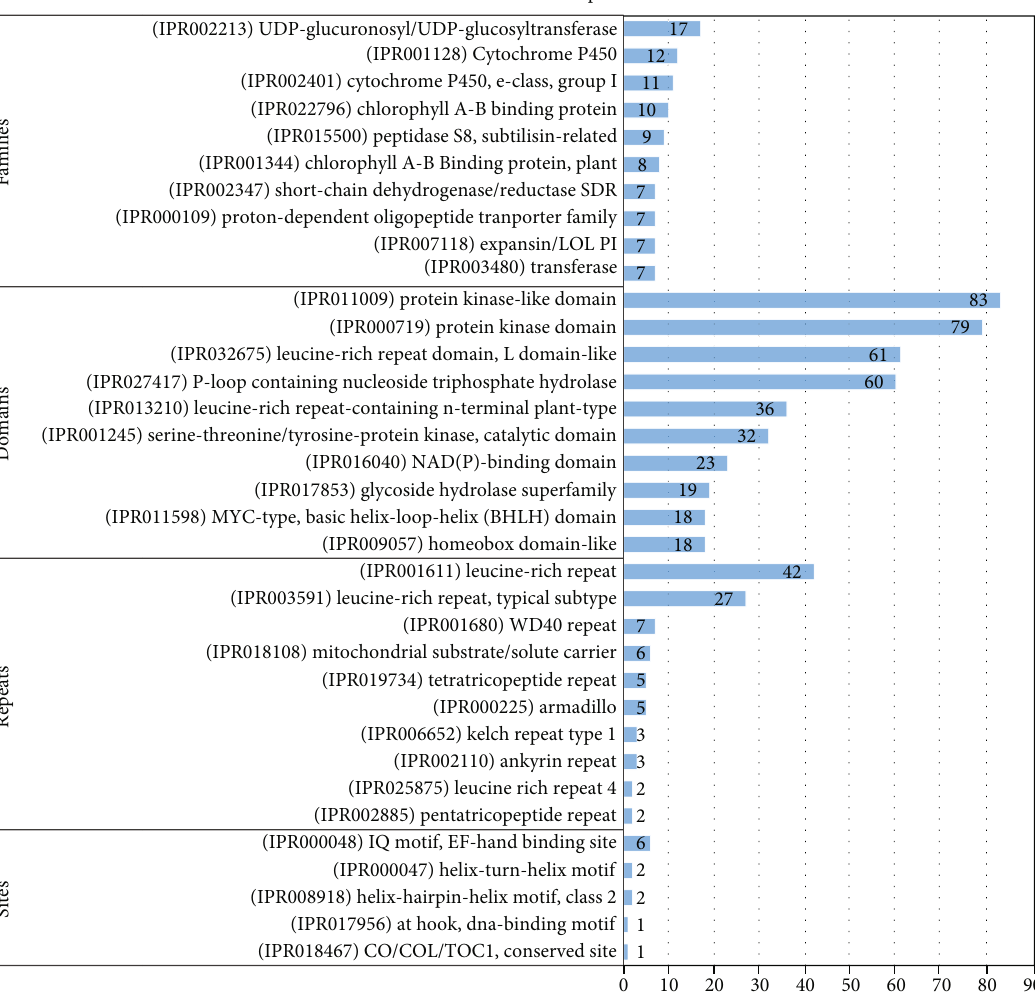
Figure 6: Top 10 IPS families, domains, repeats, and sites for heat stress-responsive downregulated